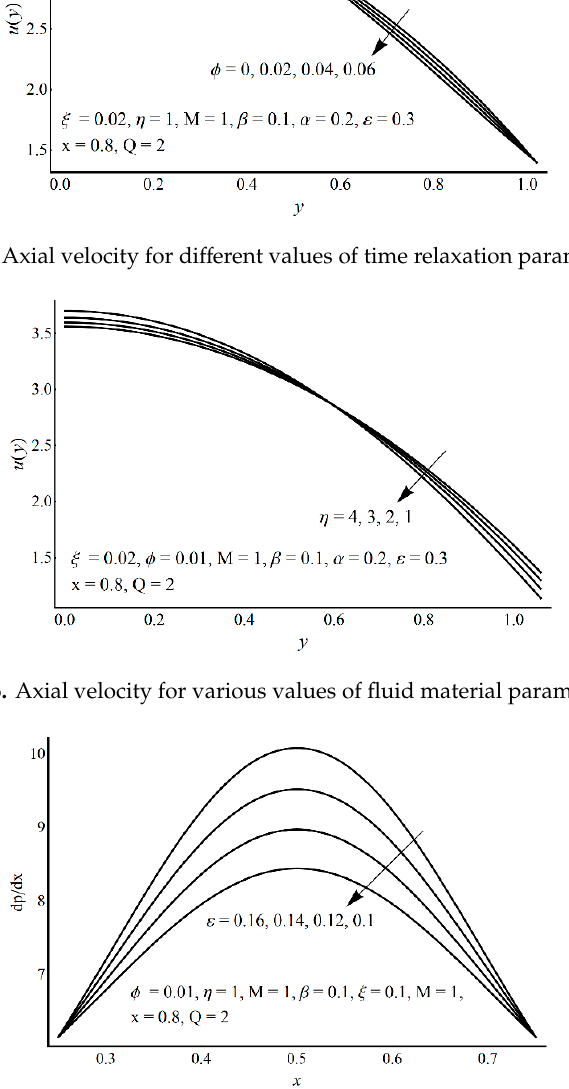
Figure 7. Pressure gradient at various values of variable ε .